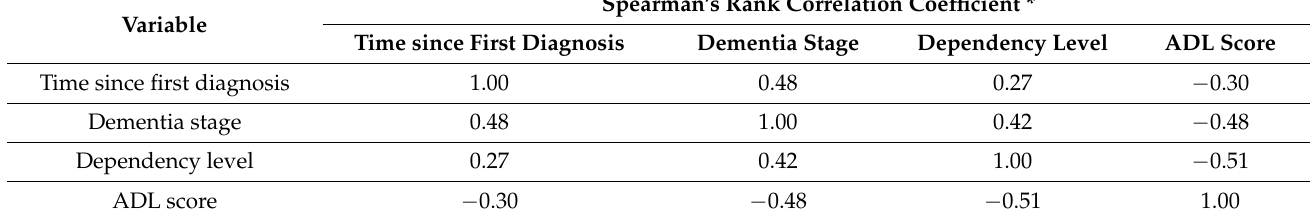
Table 4. The correlation between the Activities of Daily Living (ADL) score, time since the first diagnosis, dementia stage, and patients’ dependency level (Spearman’s rank correlation coefficient). Spearman’s Rank Correlation Coefficient * Variable